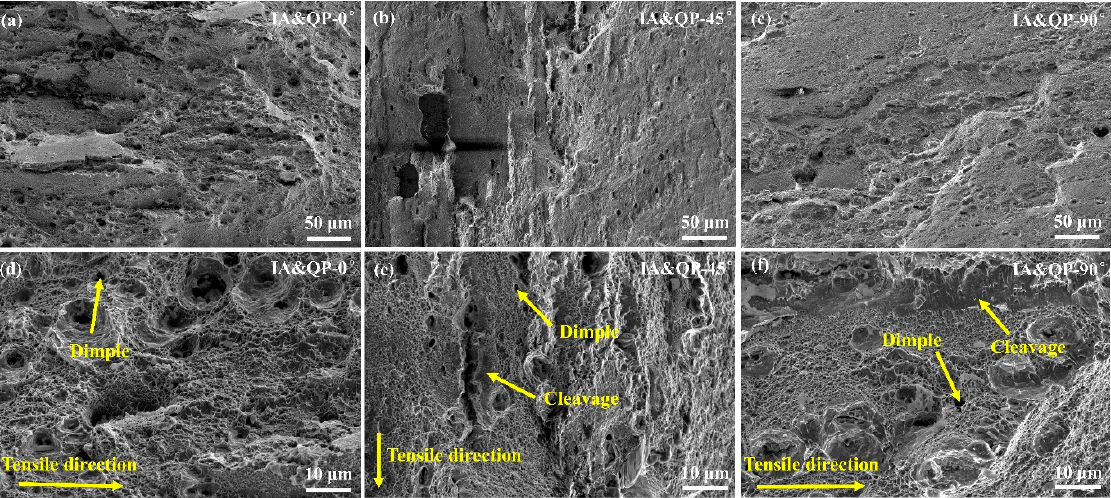
Figure 7. Fracture morphology of the IA-Q&P steel after the uniaxial tensile test along the ( a , d ) 0°, ( b , e ) 45°, and ( c , f ) 90° directions with respect to the rolling direction; ( d – f ) is a magnified view of ( a – c ).